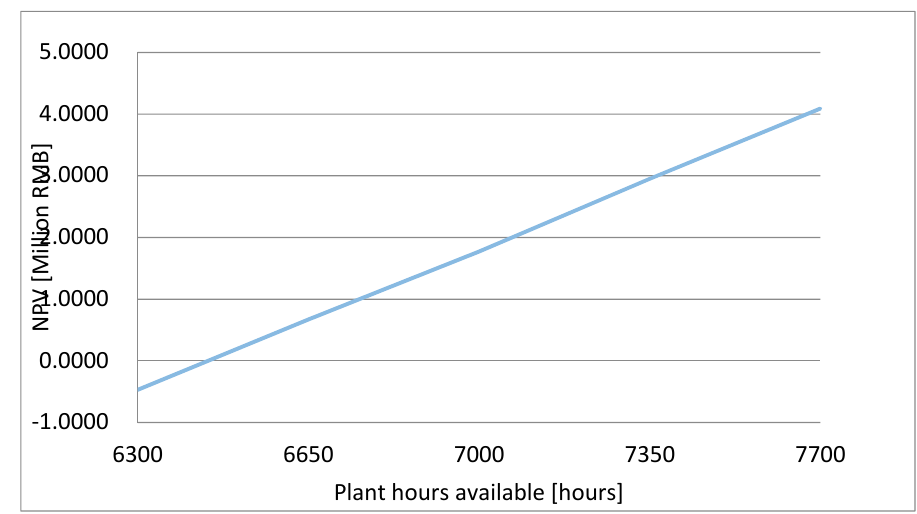
Figure 11. Plant availability as a function of NPV.